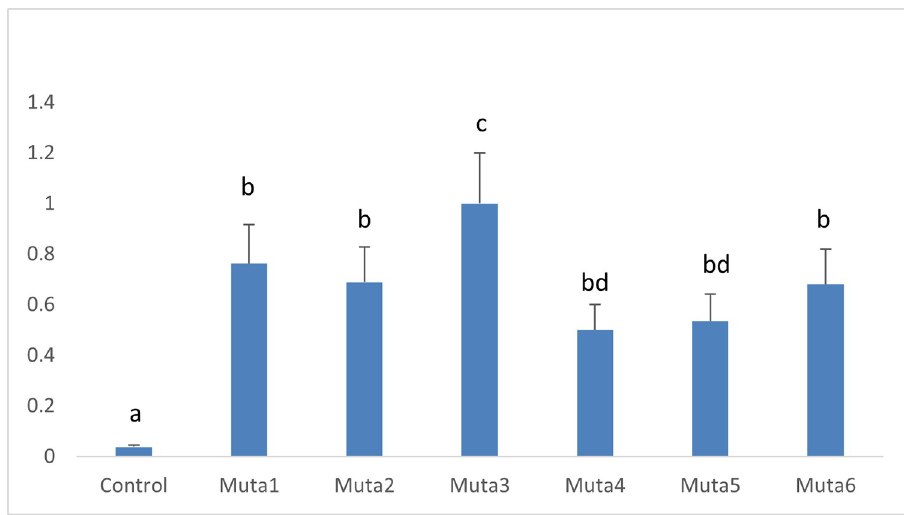
Fig 8. RT-qPCR analysis of T1 transgenic maize plants. Muta1—Muta6 indicating different transgenic lines. Values are expression mean ± standard error and different letter indicate significant different (p < 0.05).